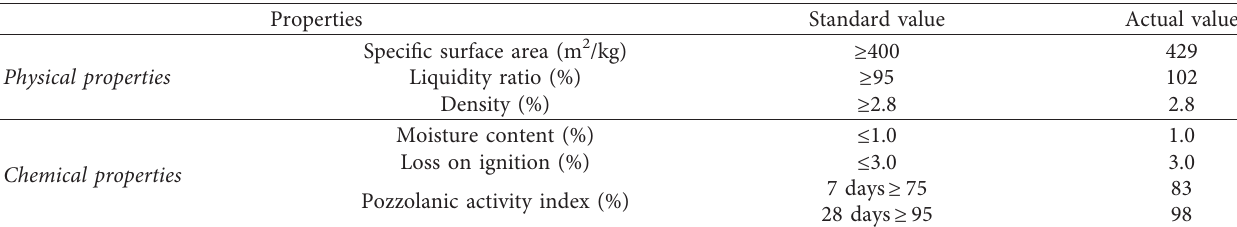
Table 4: Physical and chemical properties of mineral